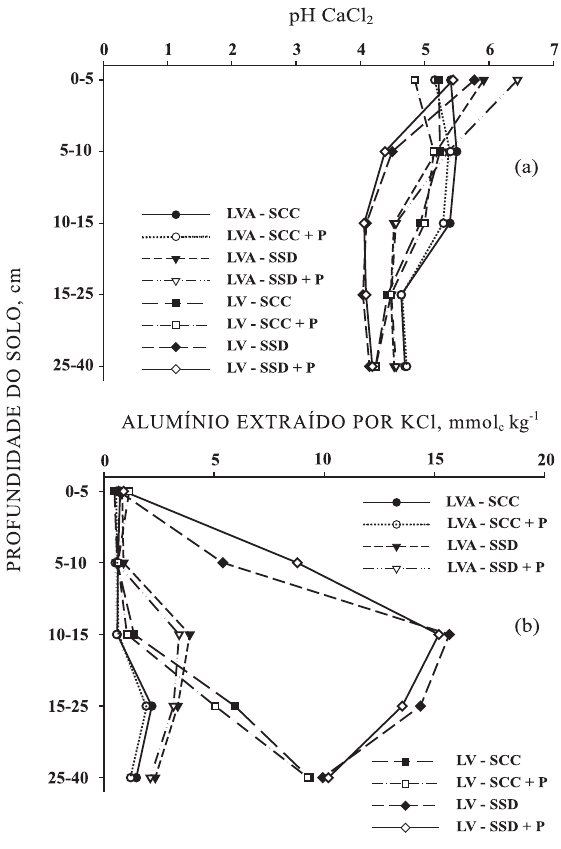
Figura 2. Valores de pH CaCl (a) e teores de acidez 2 trocável (b) nos solos LVA e LV sob dois sistemas de manejo (SCC e SSD), sem e com fertilizante fosfatado